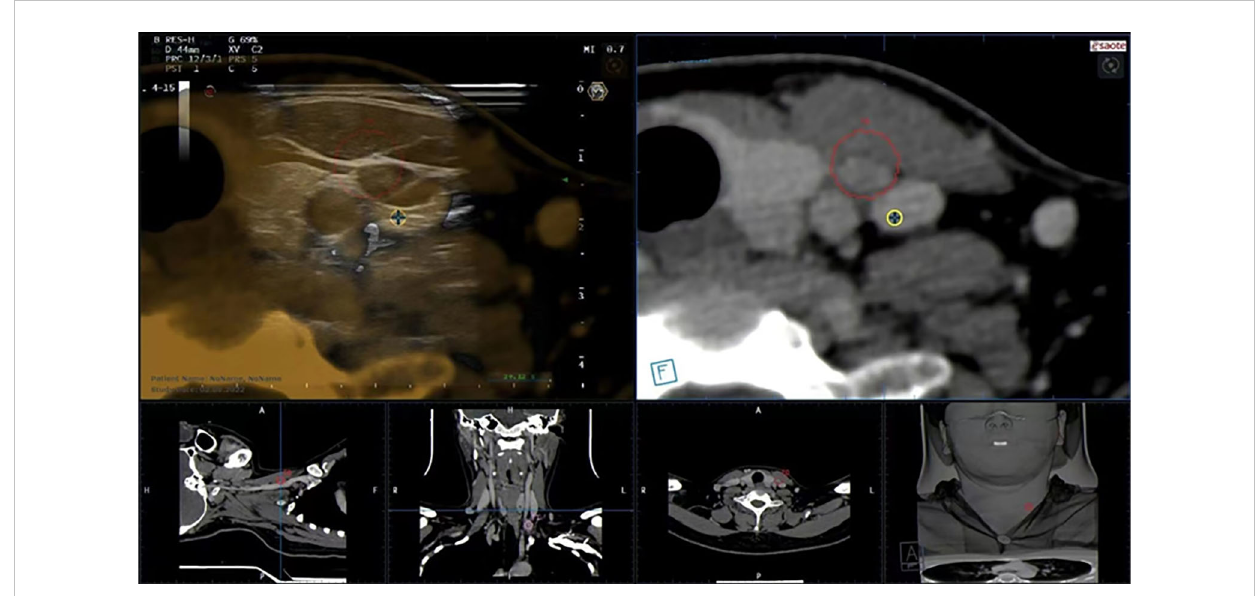
FIGURE 6 US-CT fusion imaging shows that the LN marked after image fusion was in the red circle, and LN metastasis in PTC was con fi rmed by